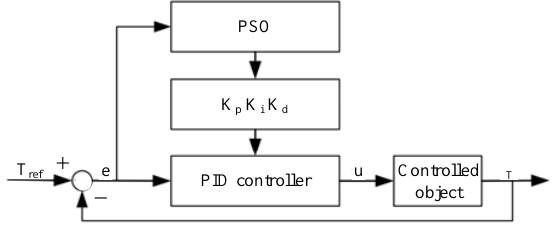
Figure 11. Schematic diagram of PSO PI implementation process.